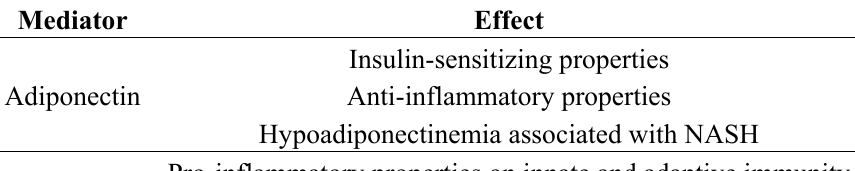
Table 1. Adipokines and other soluble mediators